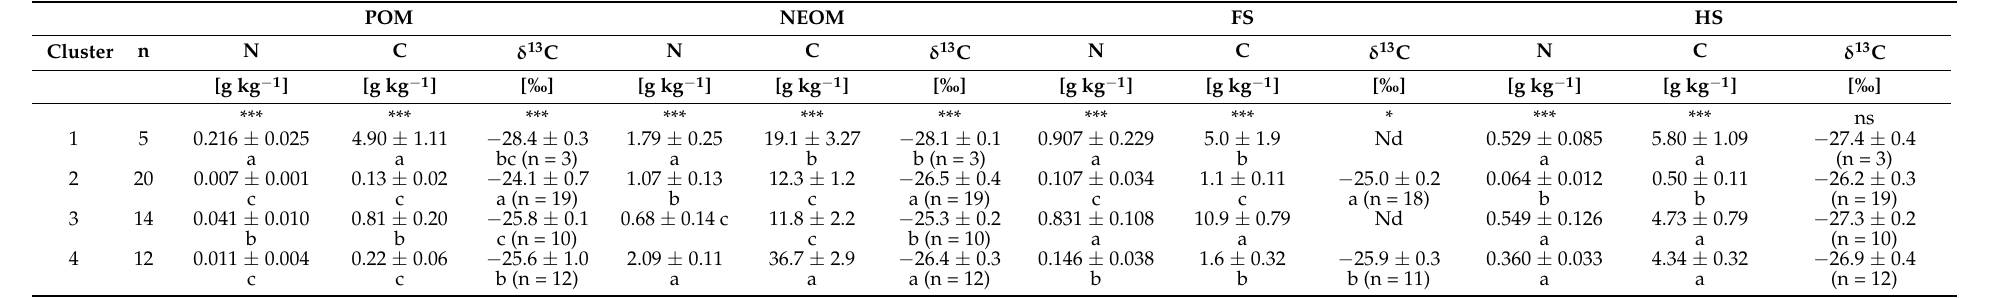
Table 3. Means ± standard errors of the carbon and nitrogen concentrations, and δ 13 C of the soil organic matter fractions extracted from 0–15 cm deep topsoils of each cluster, with the Kruskal–Wallis significance presented as letters and symbols. Within each column, means with different letters indicate significant differences. * p -value < 0.05; *** p -value < 0.001; ns—not